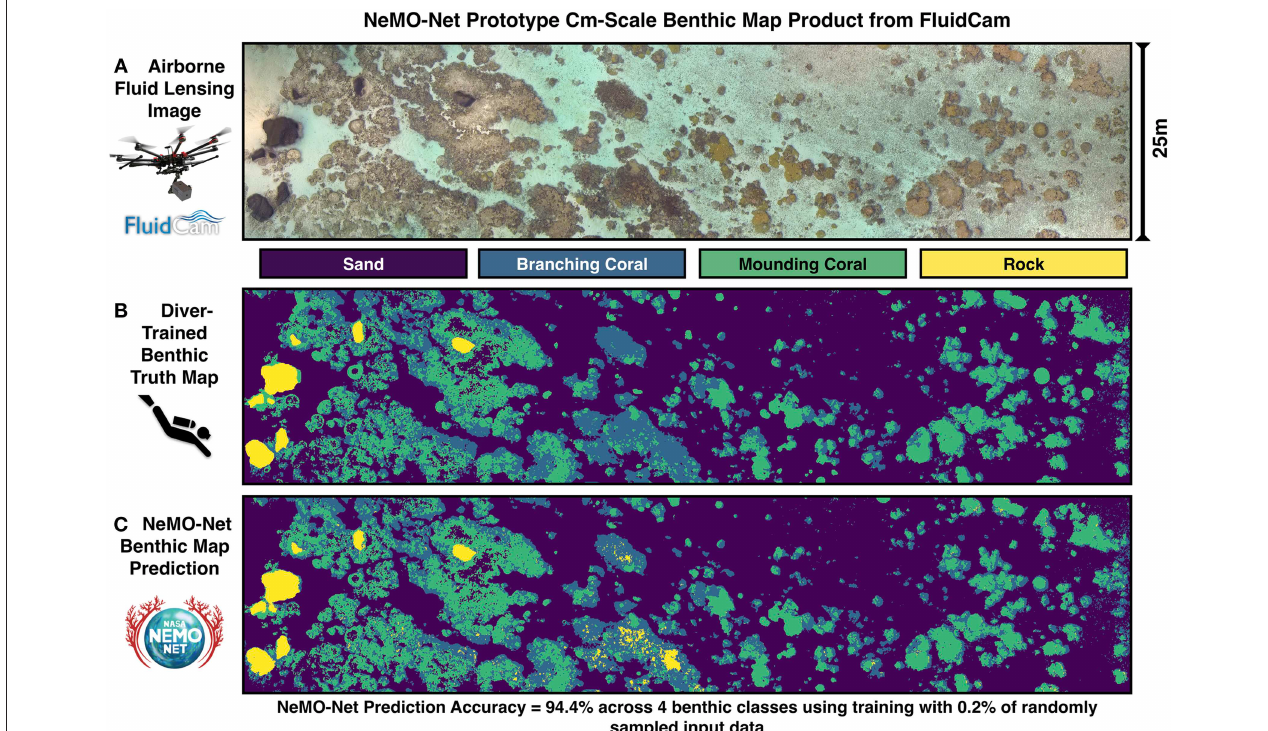
FIGURE 15 | Preliminary NeMO-Net CNN benthic mapping predictions using FluidCam data. (A) Cm-scale 2D and 3D multispectral data are input into NeMO-Net from airborne fluid lensing campaigns. (B) To test accuracy of NeMO-Net prediction, divers meticulously surveyed this entire transect to produce a benthic habitat map of the coral reef to use as truth, or reference data (Chirayath and Instrella, accepted). The reef transect was classified into four classes; sand, rock, mounding coral, and branching coral. (C) The diver data were randomly sampled to label 0.2% of the FluidCam data for training the NeMO-Net model on the NASA Ames Supercomputer. As a result, the NeMO-Net CNN is able to predict the entire benthic map from FluidCam data (A) , with a total accuracy across all four classes of